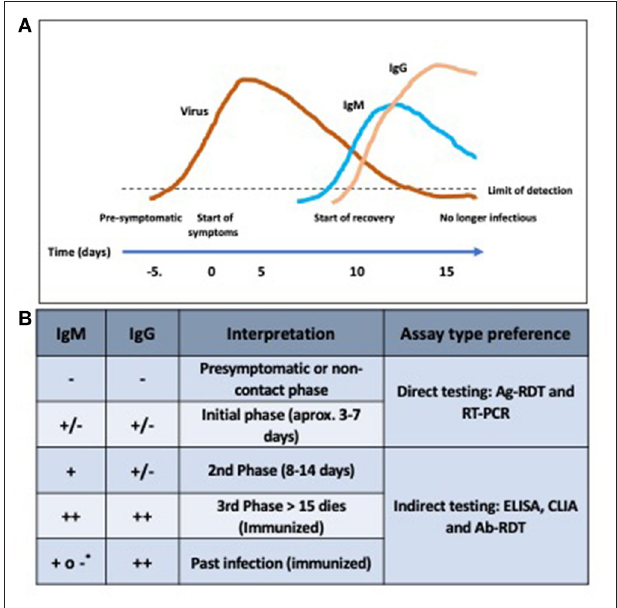
FIGURE 2 | The course of infection according to antibody lecture. (A) Antigen shedding and antibody kinetics profile along the course of infection. Antigen levels persist despite the appearance of antibodies. Thus, active infection can be diagnosed either by either antigen or antibody detection. (B) Interpretation of the presence of antibodies. *IgM + can appear as in some cases IgM can last